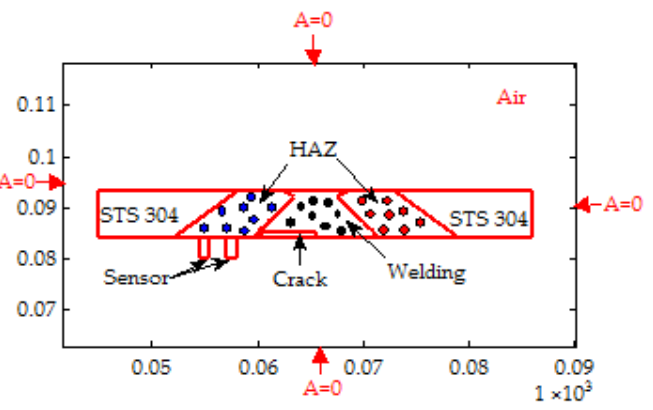
Figure 5. Solving domain and boundary conditions.